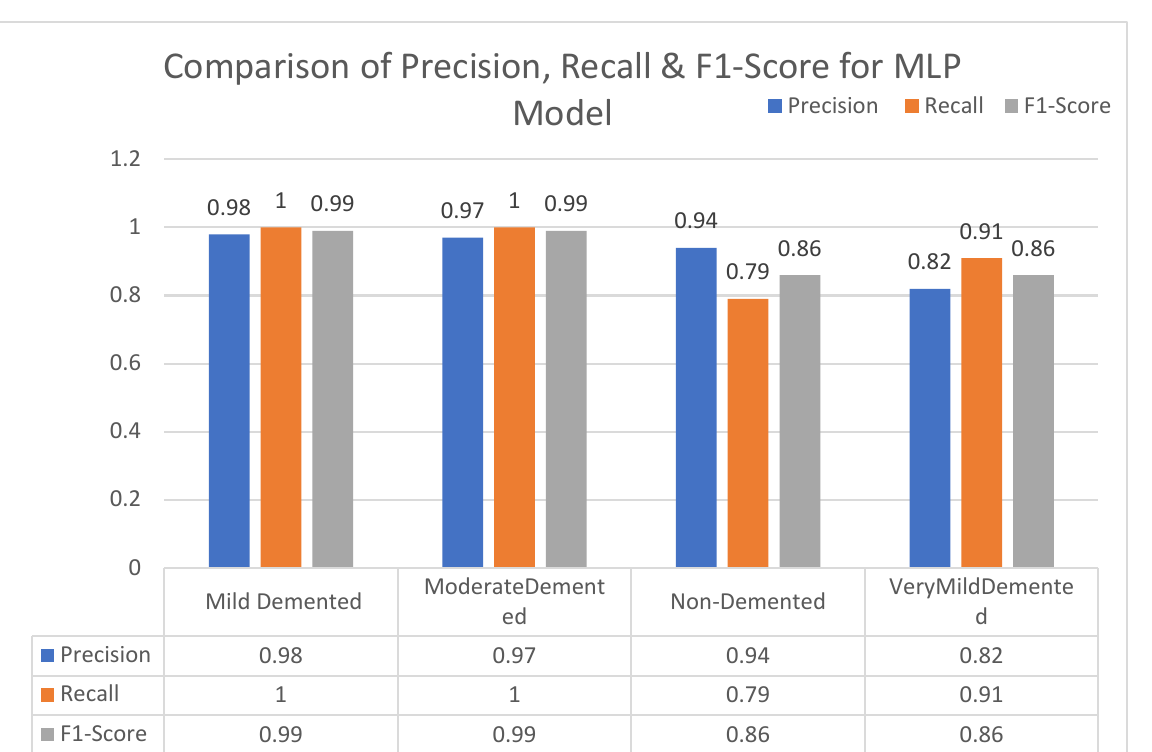
Figure 13. Visualization of Diagnostic Test for SVM Model.